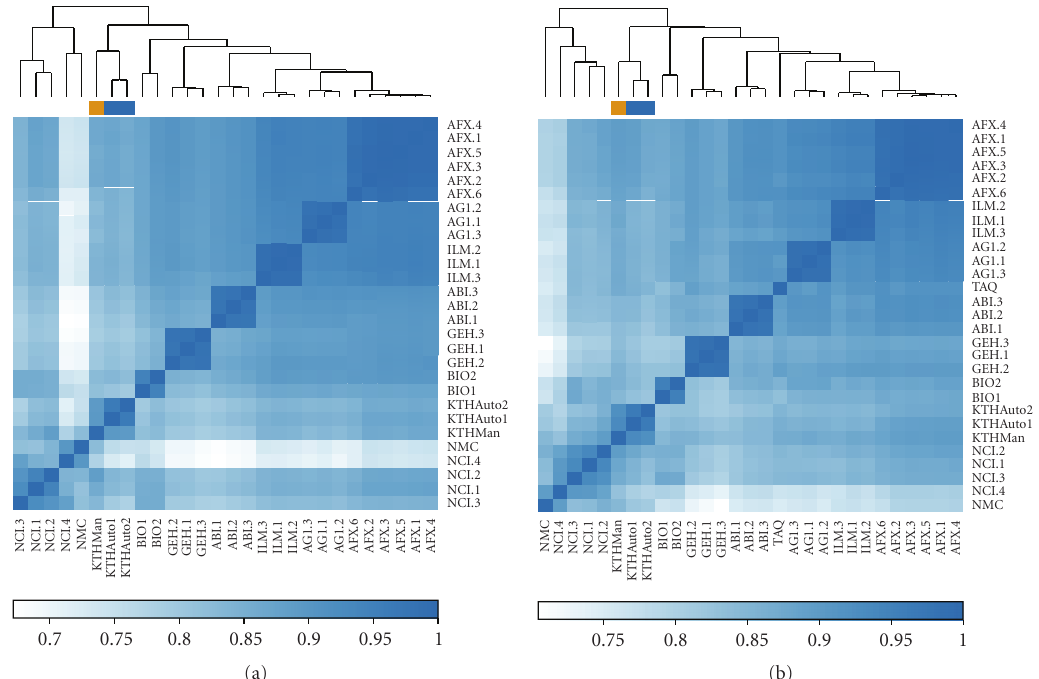
Figure 4: Dendrogram and heat maps of interplatform correlations. (a) is based on the 12091 probes common to all platforms (based on the mapping procedure in the MAQC study). A distinct clustering of platforms based on identical probes manufactured by Operon is apparent (KTH Auto, KTH Man, NCI.1–3). The one-colour platforms (GEH, ABI, AG1, ILM, AFX) were generally more highly correlated than two-colour platforms (NMC, NCI, BIO, KTH). (b) is based on a subset 906 probes for which TaqMan-based relative expression levels are available. Generally, the one-colour platforms are clustered closer to the TaqMan experiment. Interestingly, the NCI.4 experiment is positioned somewhat ambiguously in the two dendrograms, possibly indicating some uncertainty in the